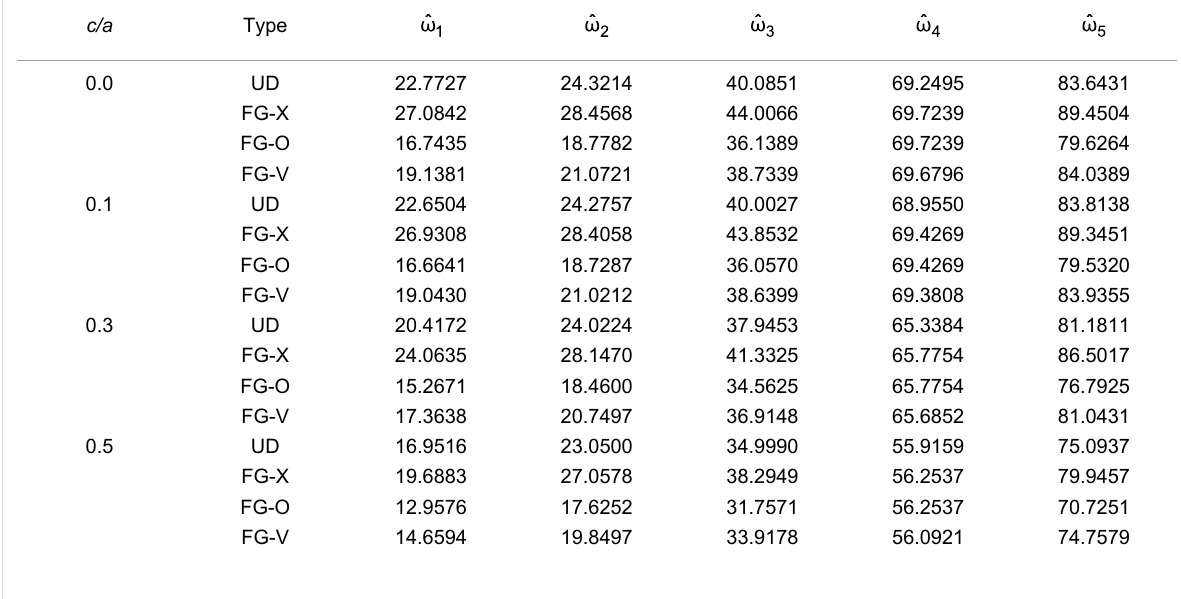
Table 9: First five natural frequency parameters for square, FG-CNTRC, CFFF plates with a centric cutout. Geometrical characteristics of the plate are a/b = 1, h/a = 0.05 with various c/a ratios. The volume fraction of CNTs is set equal to =